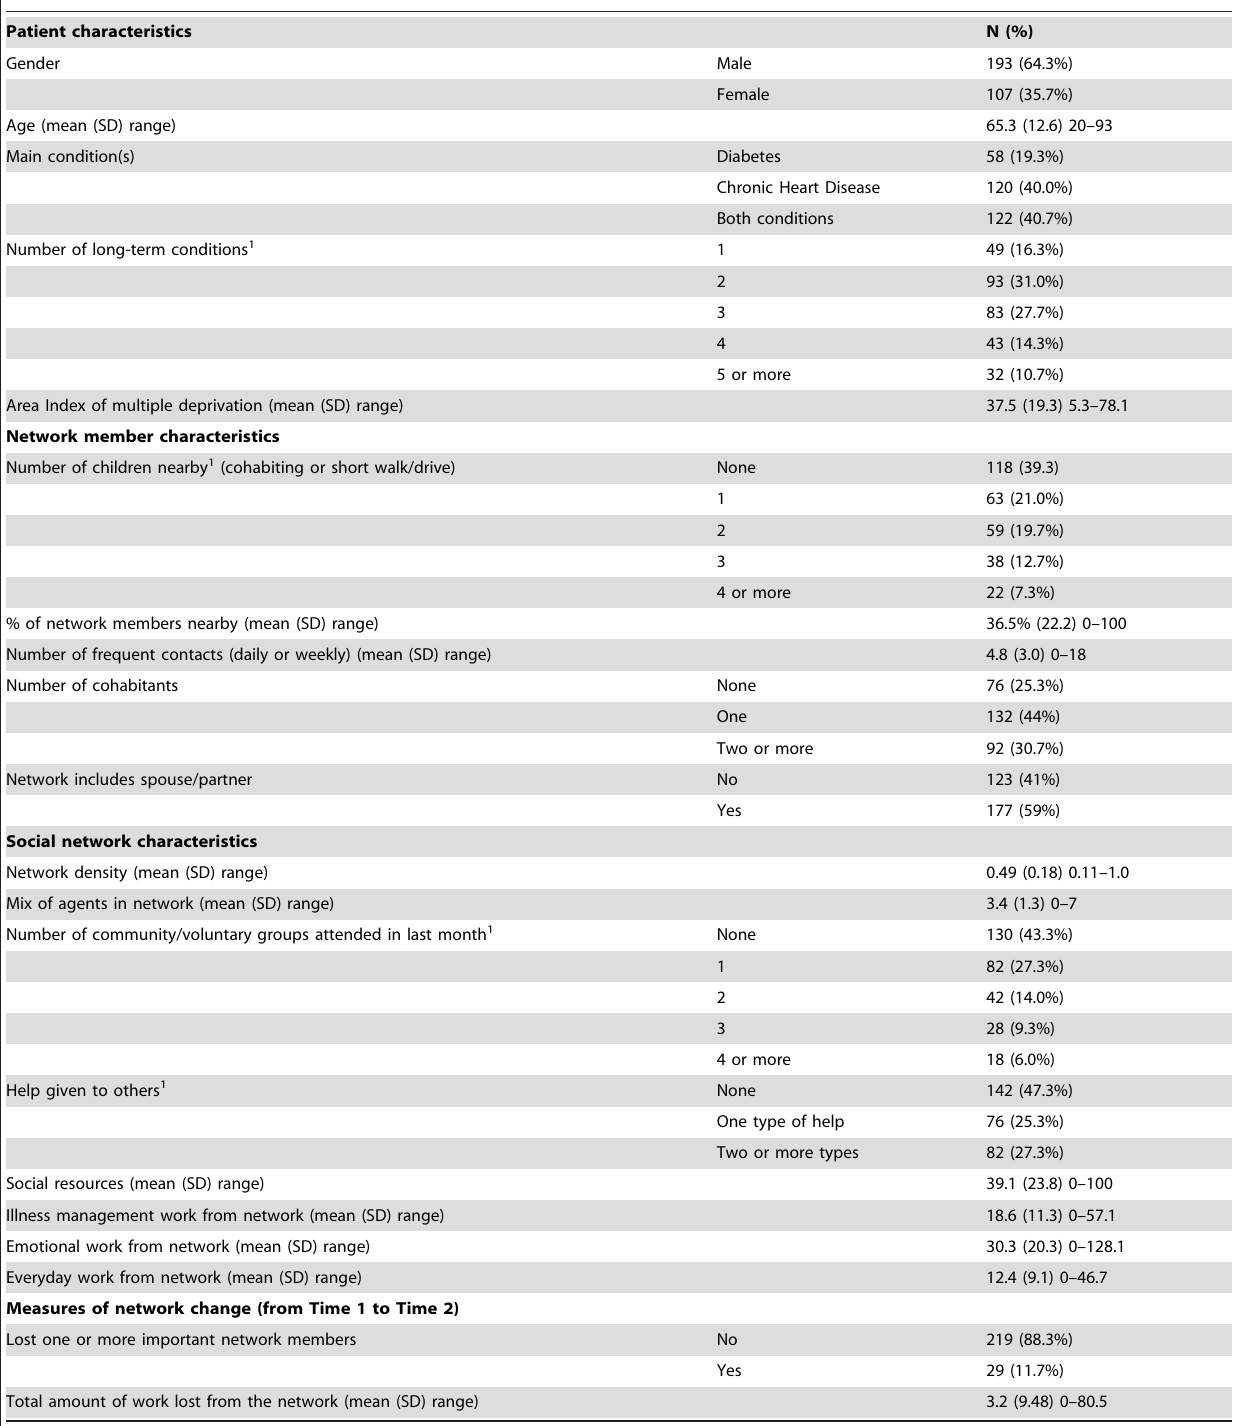
Table 1. Descriptive statistics of the